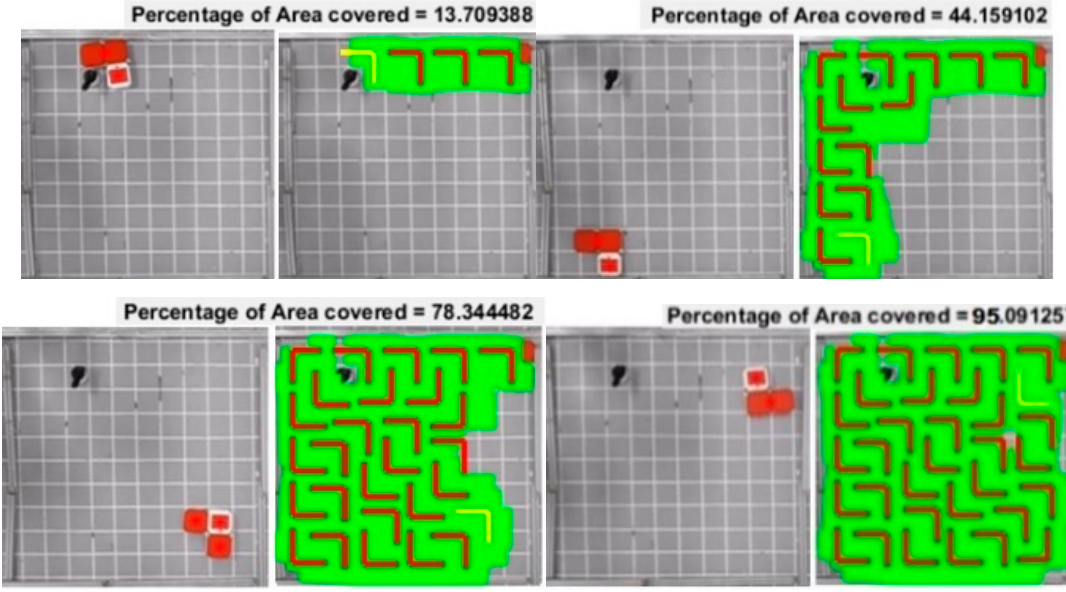
Figure 20. Tiling Process with Lemma 4 tile set.